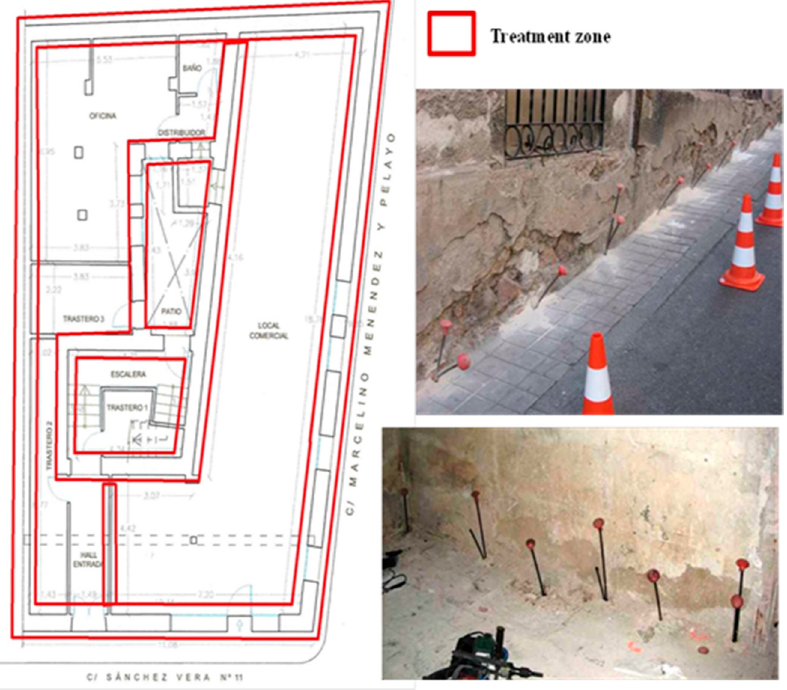
Figure 5. Image of the part of the building that was treated and details of the location of the injection tubes.